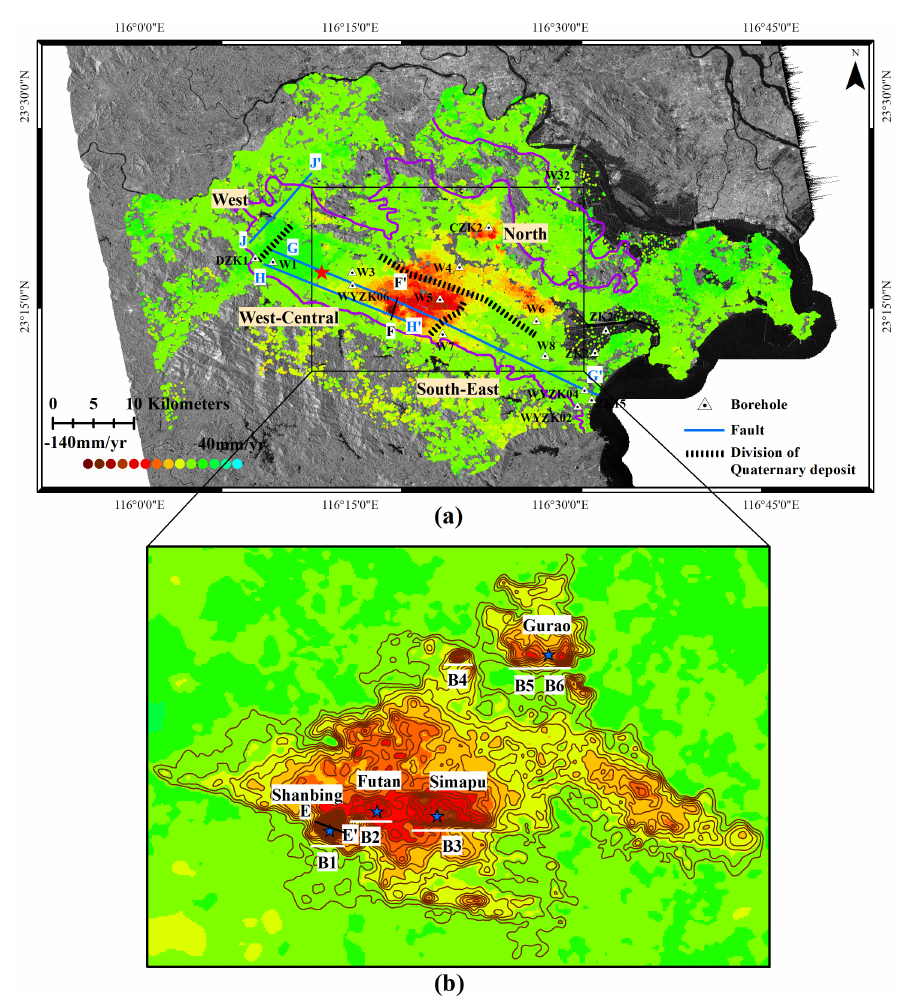
Figure 8. Spatial distribution and deformation gradient of subsidence bowls in LJP. ( a ) The triangle marks indicate sixteen boreholes (marked as W32, W4, W6, CZK2, W5, W7, DZK1, W3, WYZK06, W1, WYZK02, ZK26, ZK15, WYZK04, ZK2, and W8) distributing in the test site. The blue lines are the sections of faults. The black dashed lines are the boundaries which divide the test site into four subareas: West, West-Central, South-East and North. ( b ) B1, B2, B3, B4, B5, and B6 are subsidence bowls identified by interpolation. The blue stars indicates four sites that have been visited during the field